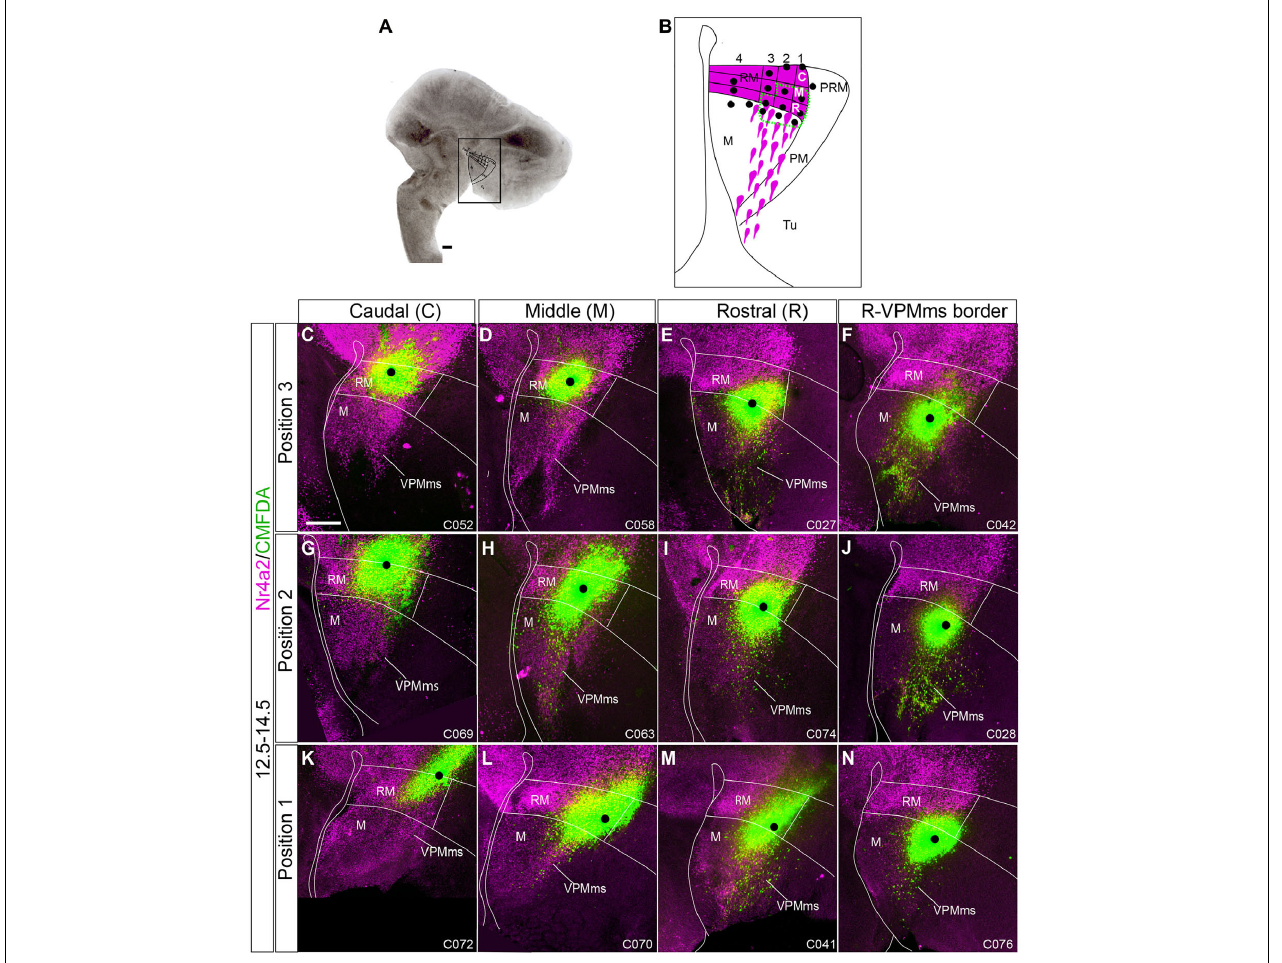
FIGURE 8 | Origin of VPMms in the dorsal half of RM. (A,B) We visualize here representative cases with marking positions within the upper half of RM, part of which labeled the VPMms; some cases labeling the VPMms itself rostral to RM are shown as well; we employ the same reference system used in Figure 7 (dorsoventral positions 1–3 indicated at the left, and rostrocaudal locations C/M/R above). CMDFA marking signal is in green and Nr4a2 immunofluorescence is in magenta. The black dots indicate the observed labeling grain; we estimate that migrating cells lying mainly close to the grain were sufficiently labeled, irrespective of accompanying diffusion of label around it. The alphanumeric identification of the cases appears at the lower right corner (compare Supplementary Table 1 ). All cases marked in the C or M domains of position 3 (ventral tier of upper RM half) were negative ( C,D ; 3C n = 2, 3M n = 3), as were the cases marked in the C domain of positions 2 or 1 ( G,K ; 2C n = 1, 1C n = 1). The remaining cases shown were positive and show a distinct rostralward dispersion of fluorescent labeled cells (VPMms), each experiment visibly identifying only a fraction of the total VPMms cell population visualized with background Nr4a2 labeling ( E,F,H–J,L–N ; 3R n = 12; 3VPMms n = 12; 2M n = 3; 2R n = 6; 2VPMms n = 8; 1M n = 3; 1R n = 2; 1VPMms n = 3 Supplementary Table 3 ). Scale bars represent 200 µ